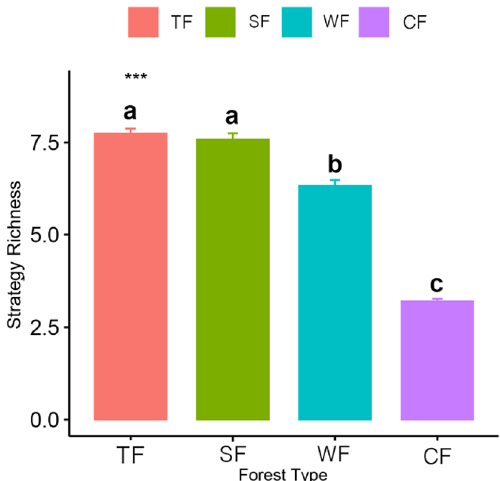
Figure 2. Variations in ecological strategy richness in different forest vegetation types across four climatic zones in China. TF tropical rainforest, Red, SF subtropical evergreen-deciduous broadleaved mixed forest, Green, WF warm-temperate coniferous-broadleaved mixed forest, Blue, CF cold-temperate coniferous forest, Purple. Number of replicates N = 50 and means and standard errors are given. *** (P < 0.001) indicates significant difference in ecological strategy richness in different forest vegetation types across four climatic zones in China. Different letters denote significant difference between typical forest vegetation types (P < 0.05).